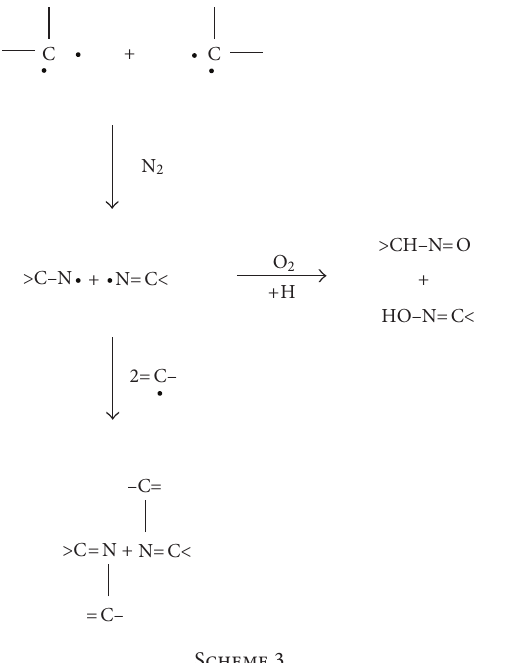
m 92 m) of polyethylene aer PIII treatment. e wave structure appears aer PIII m. e average wave’s period is 2.3 m. 𝜇𝜇 × 𝜇𝜇 𝜇𝜇 𝜇𝜇